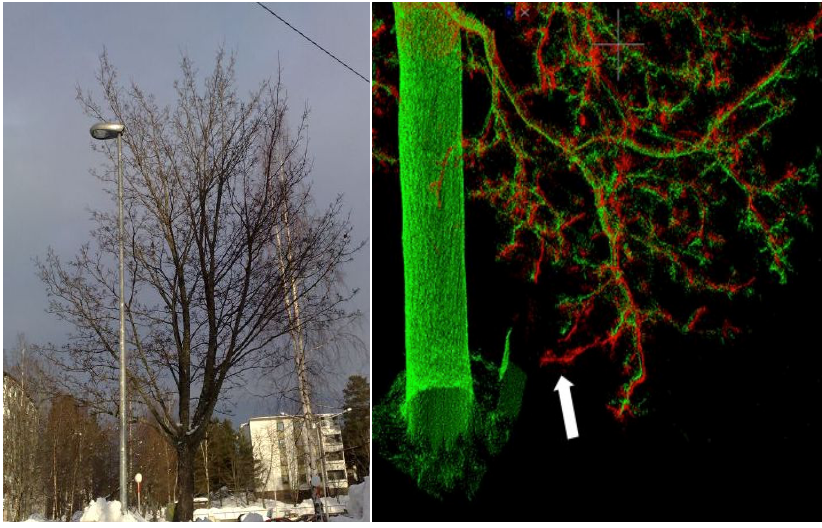
Figure 1. ( Left ) the maple tree in Espoonlahti (photographed February 2011). Some of the white spherical reference targets used for registration are also visible, between the lamp post and the tree; ( Right ) a section of the point clouds from February 2011 (red) and November 2011 (green), showing a missing branch denoted by an